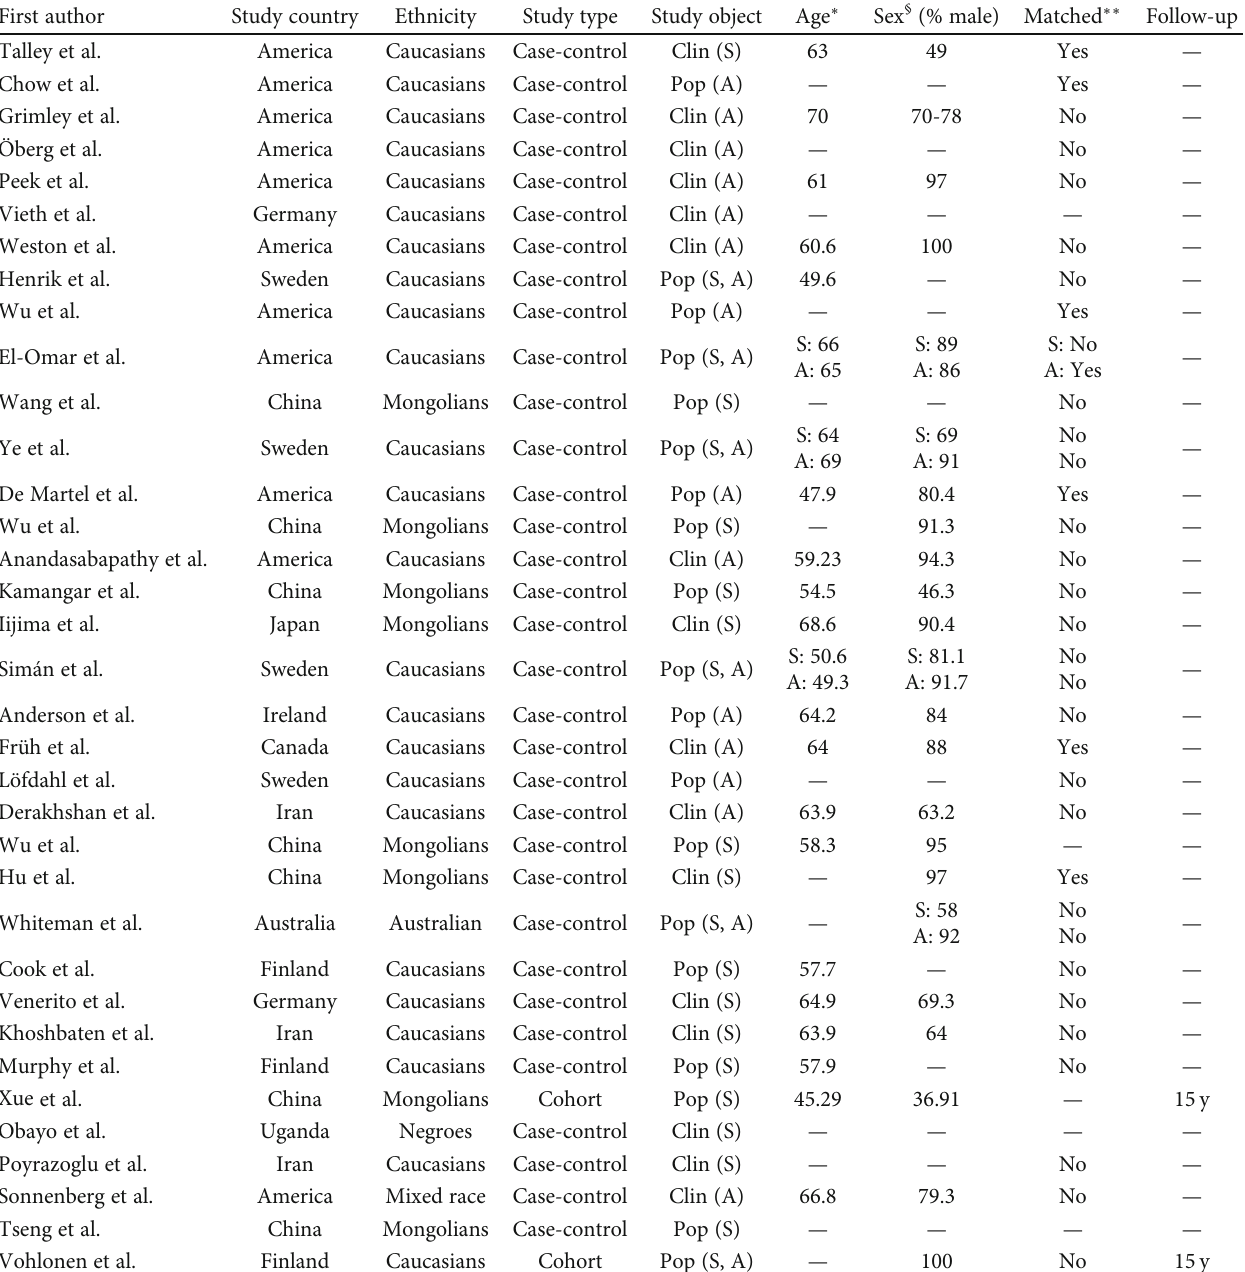
Table 1: Characteristics of literatures included in the